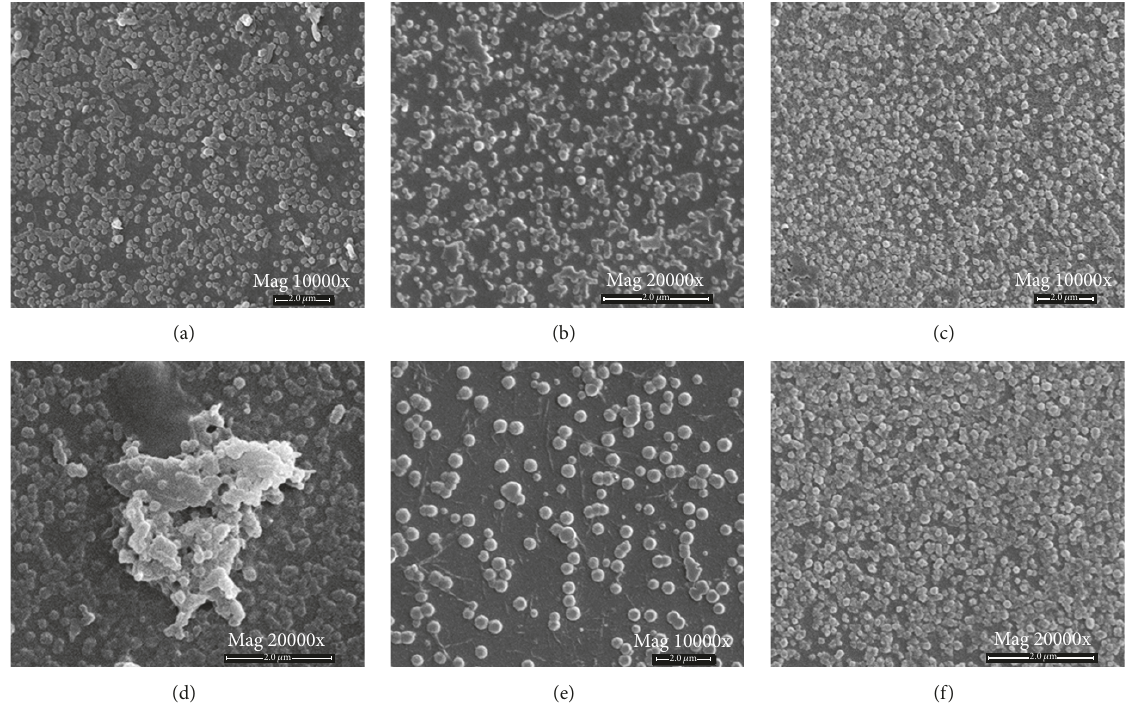
Figure 5: SEM images of HCPTNPs using ASS as surfactants under different HP and amount conditions: (a) 0.5 mg, 600bar; (b) 0.5 mg,